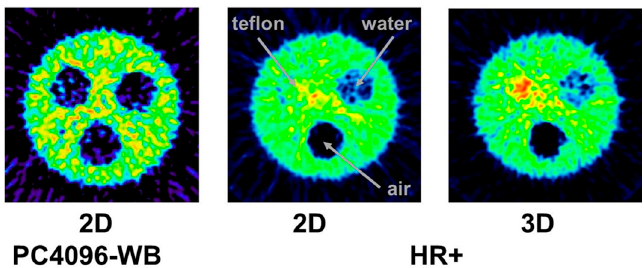
Figure 7. The three-rod phantom filled with 86 Y was comparatively scanned with the 2D-PET Scanditronix/GE PC4096-WB and with the Siemens/ECAT Exact HR+ operated both in 2D- and 3D-mode (for further details, see the text).